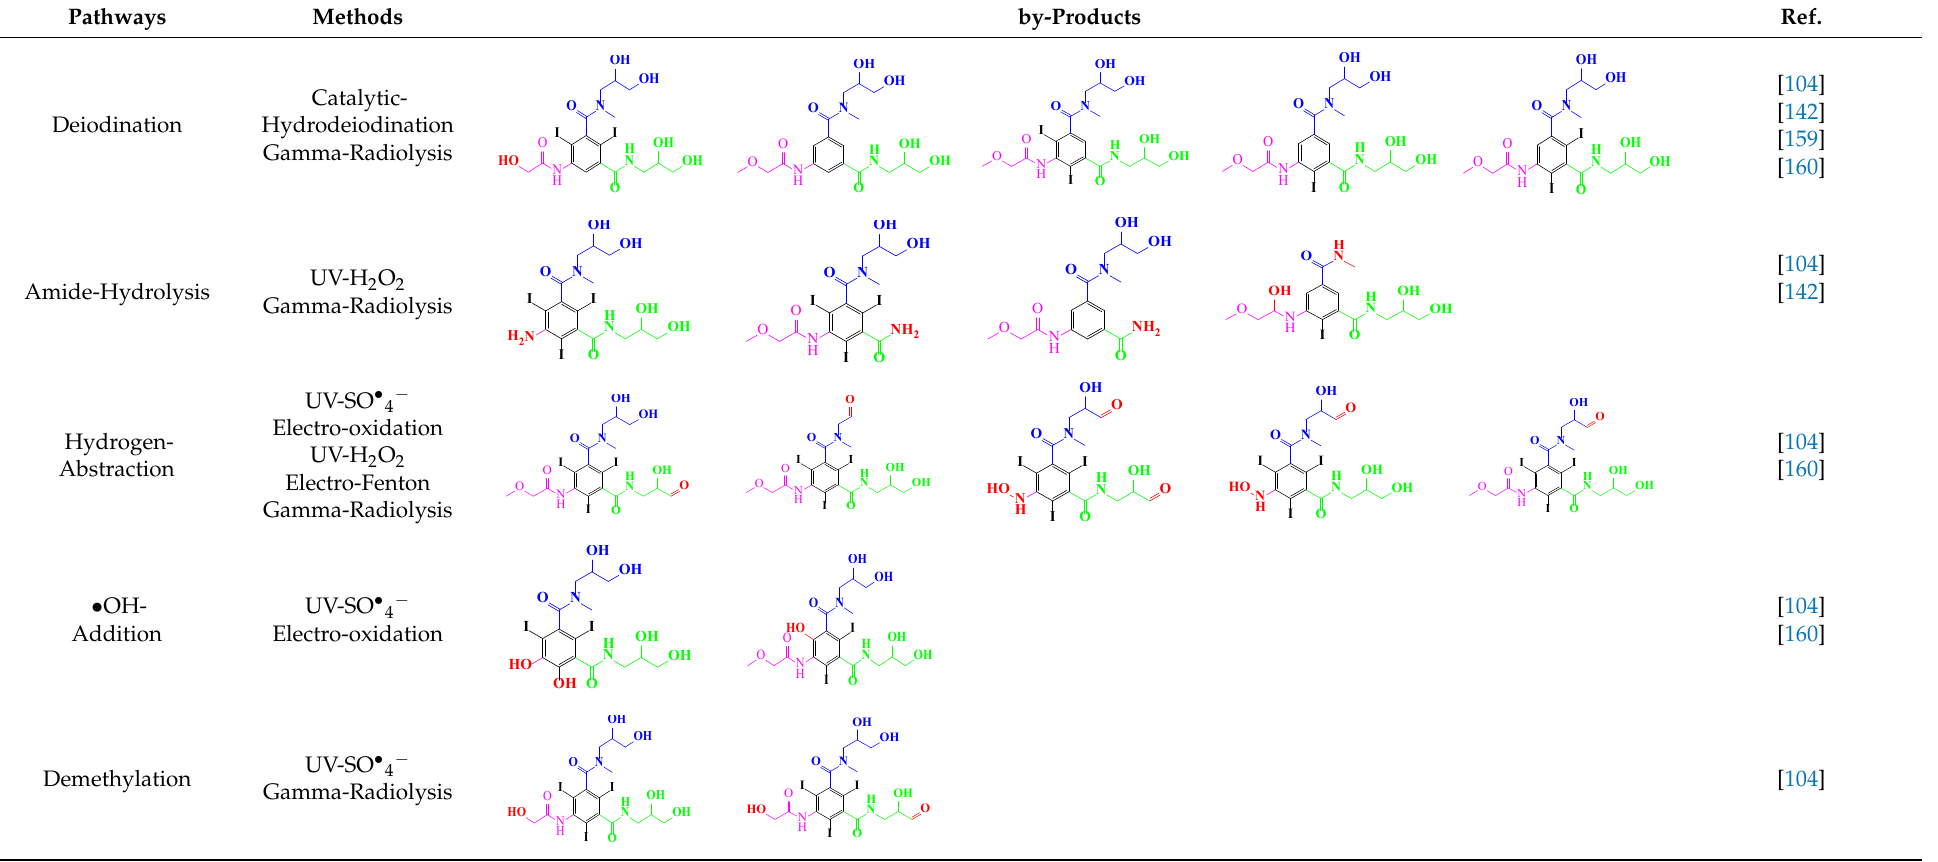
Table 9. Identified by-products of iopromide in recent literature.